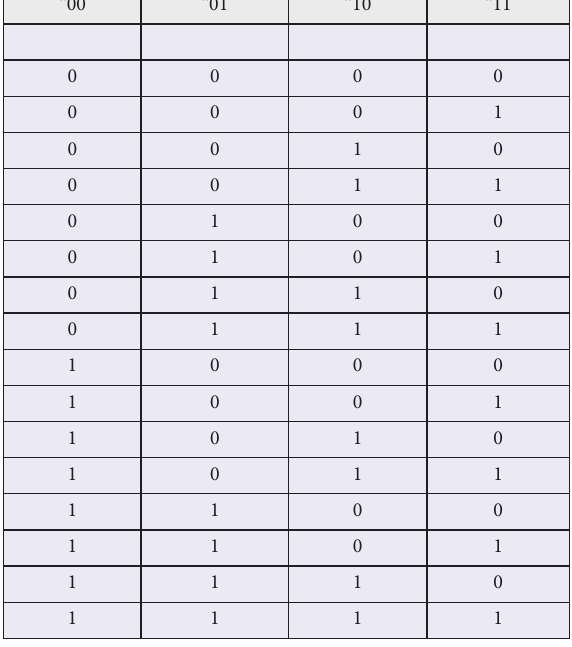
Figure 2: Diferent patterns